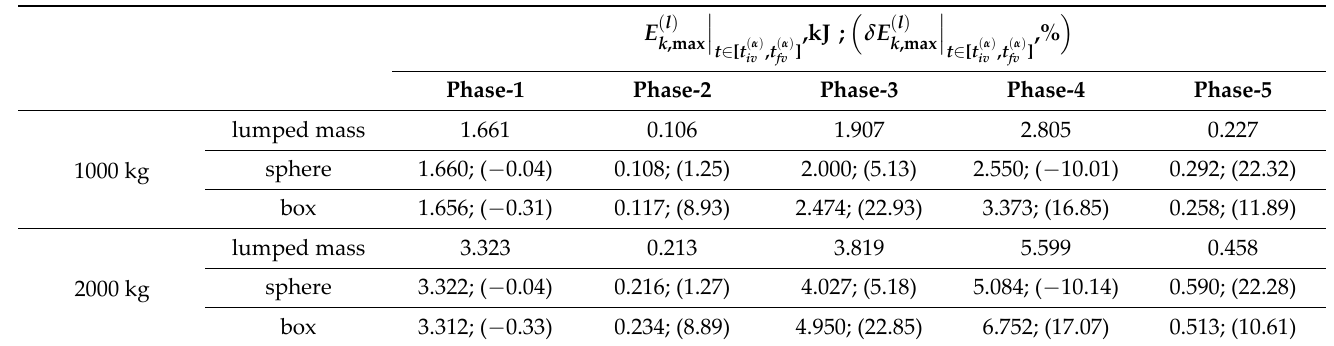
Table 2. Values of the kinetic energy in the movement phases and their relative percentage devia‑ tions.